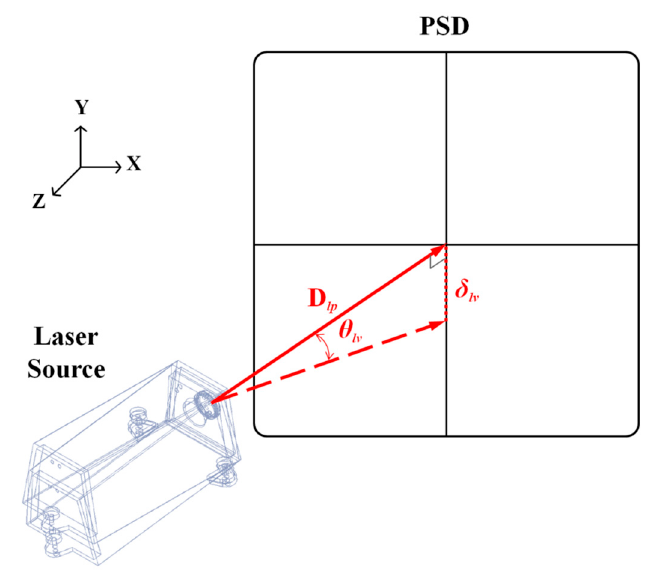
Figure 9. Vertical setup error of the laser source. Table 1. Error analysis of the laser source at vertical or horizontal directions.